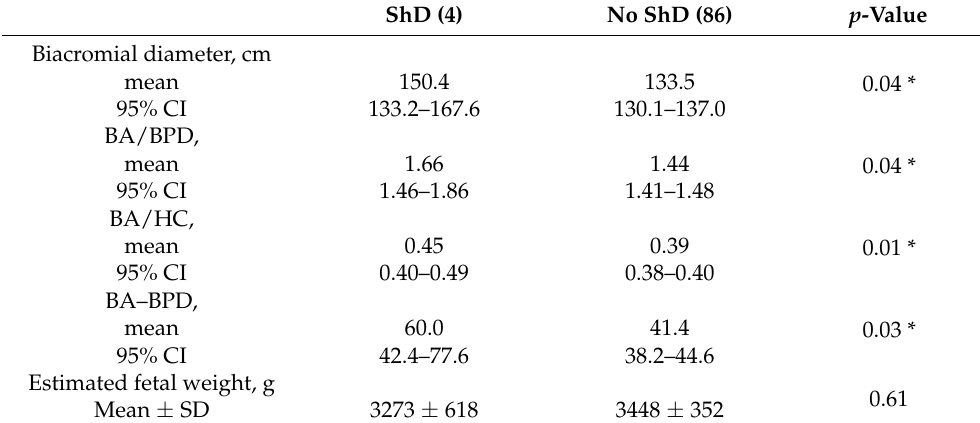
Table 2. Ultrasonographic fetal measurements.